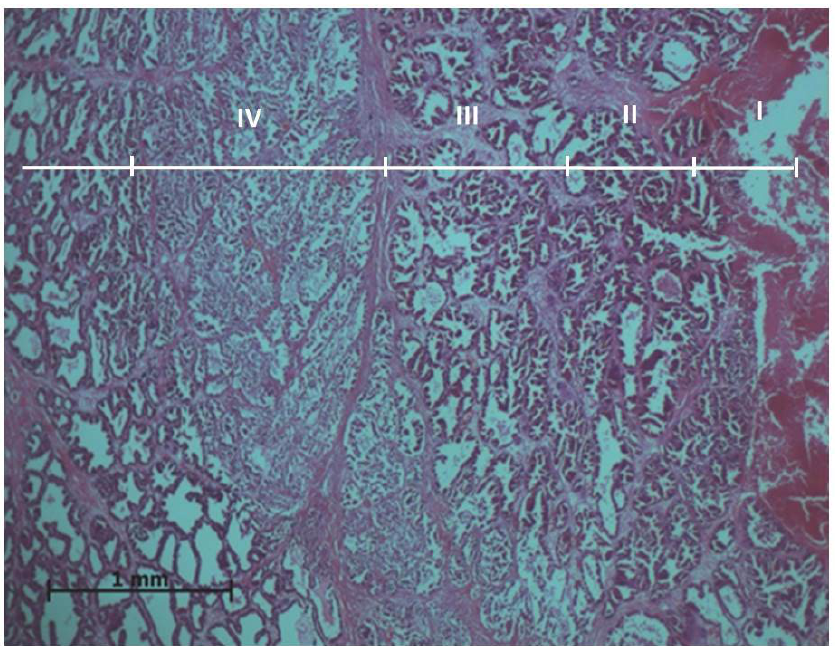
Figure 1. General histologic image of the prostate after ablation: I—ablation site; II—application zone; III—necrosis zone; IV—transition zone. Microtome-cut sections of prostate samples were stained with hematoxylin and eosin.